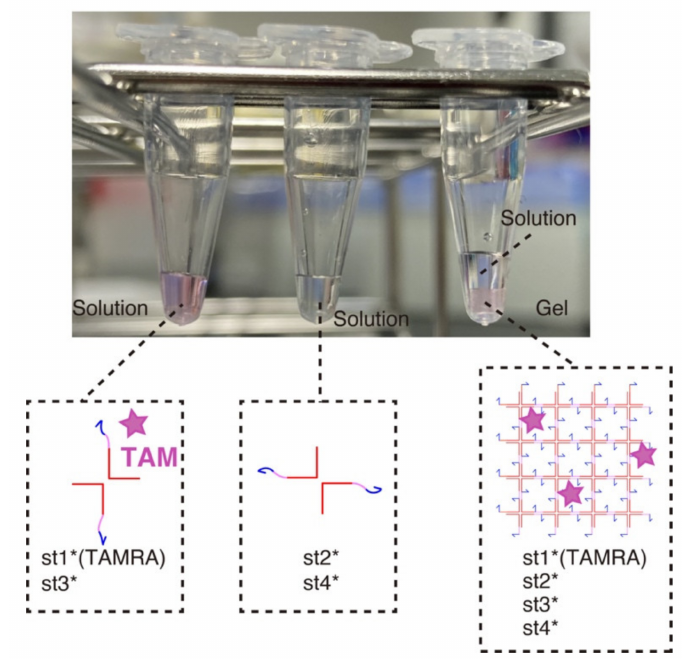
Figure 3. Macroscopic visualization of the DNA hydrogel. Three combinations of strands were mixed in a PCR tube and left at room temperature for about 15 min. The left and middle tubes contain st1*(TAMRA)-st3* strands and st2*-st4* strands, respectively (80 µ M for each strand). The strands remained in the solution phase because no complete X-motif monomer can be formed. The right tube contains 20 µ L of each of the left two tubes with addition of the buffer. After 15 min of incubation, the assembly of the X-motifs into a 3D gel became visible. The content of the tube was visibly separated into two phase, one solution phase and one gel phase.